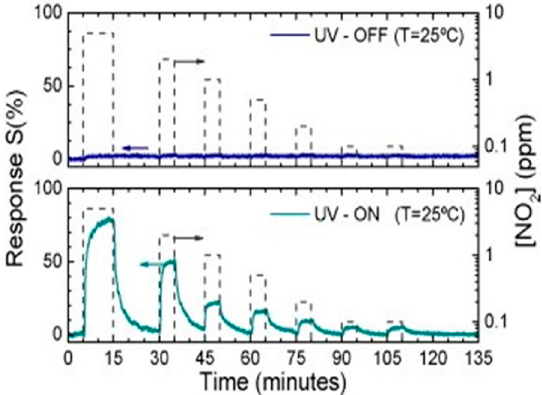
Figure 26. Dynamic NO 2 sensing curve of an individual SnO 2 nanowire, operating in dark and UV illumination at room temperature ( T = 25 °C). Dashed lines indicate the NO 2 concentration. Reproduced with permission from [39]. Micromachines 2017 , 8 , 333 18 of 53